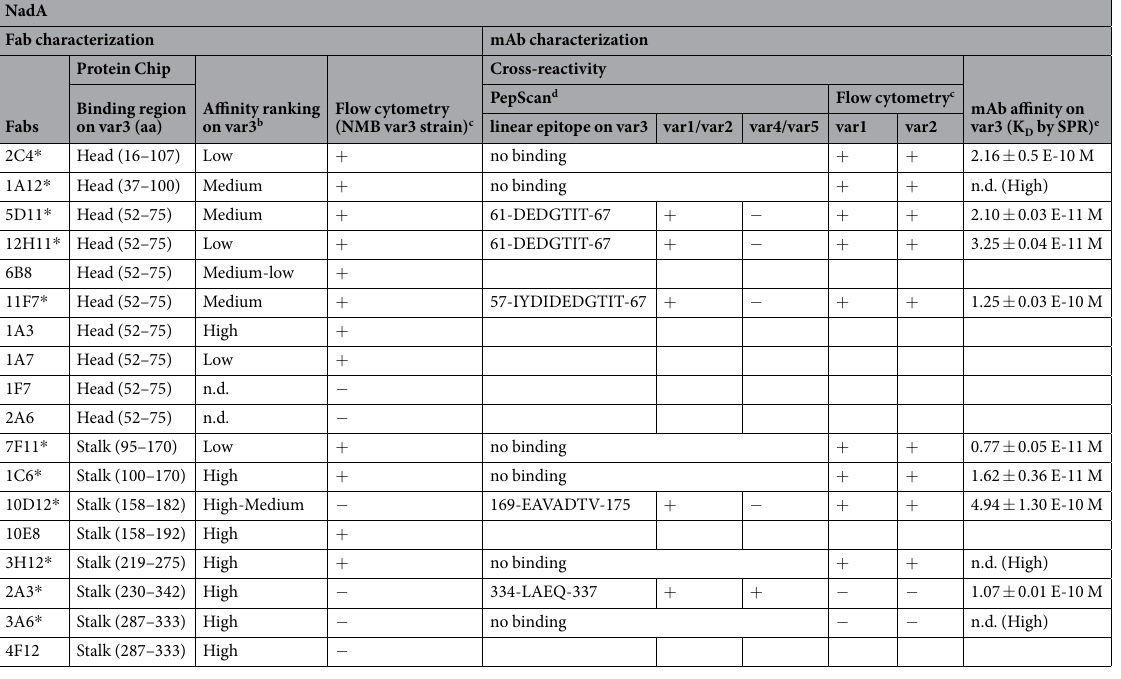
Table 4. Main features of selected anti-NadA Fabs and mAbs. * ,b,c,e See Table 2. d For mAbs characterization, linear epitopes identified by PepScan on NadA 4CMenB variant are reported when available while “no binding” indicates that no signal was detected in tested conditions; cross-reactivity to other NadA variants (var1, var2, var4 and var5), identified by PepScan, is indicated as “ + ” or “ −